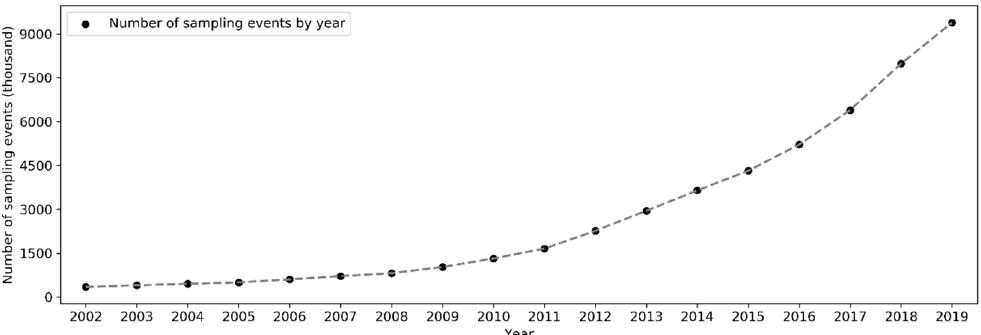
Figure 5. Number of sampling events in each year (2002–2019).